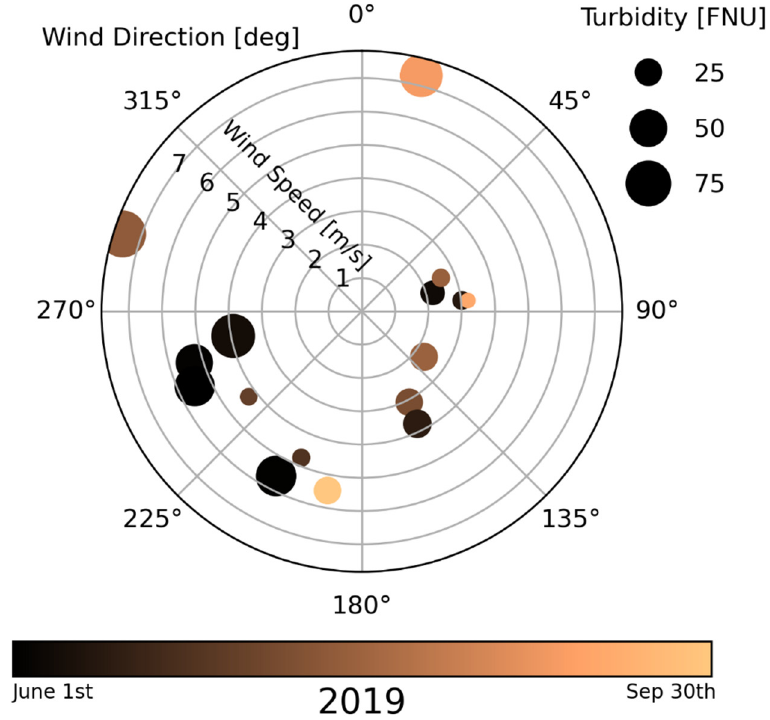
Figure 6. Rose diagram showing the dependence of nearshore turbidity on wind speed (reanalysis data from the shelf) and wind direction (in situ data from HIQ).